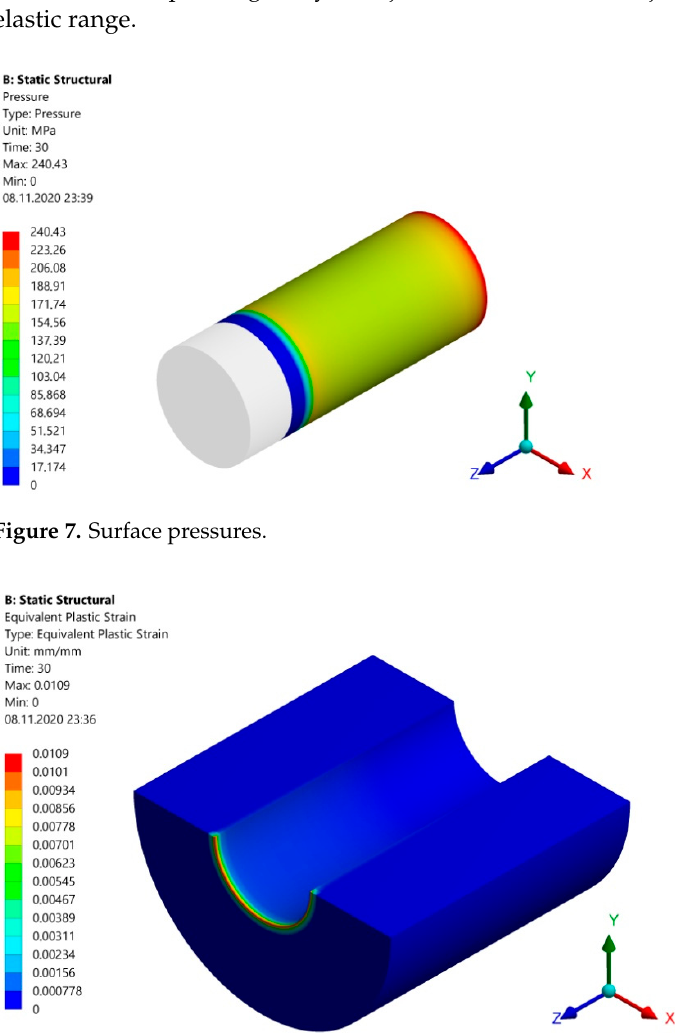
Figure 8. Plastic strain contour.